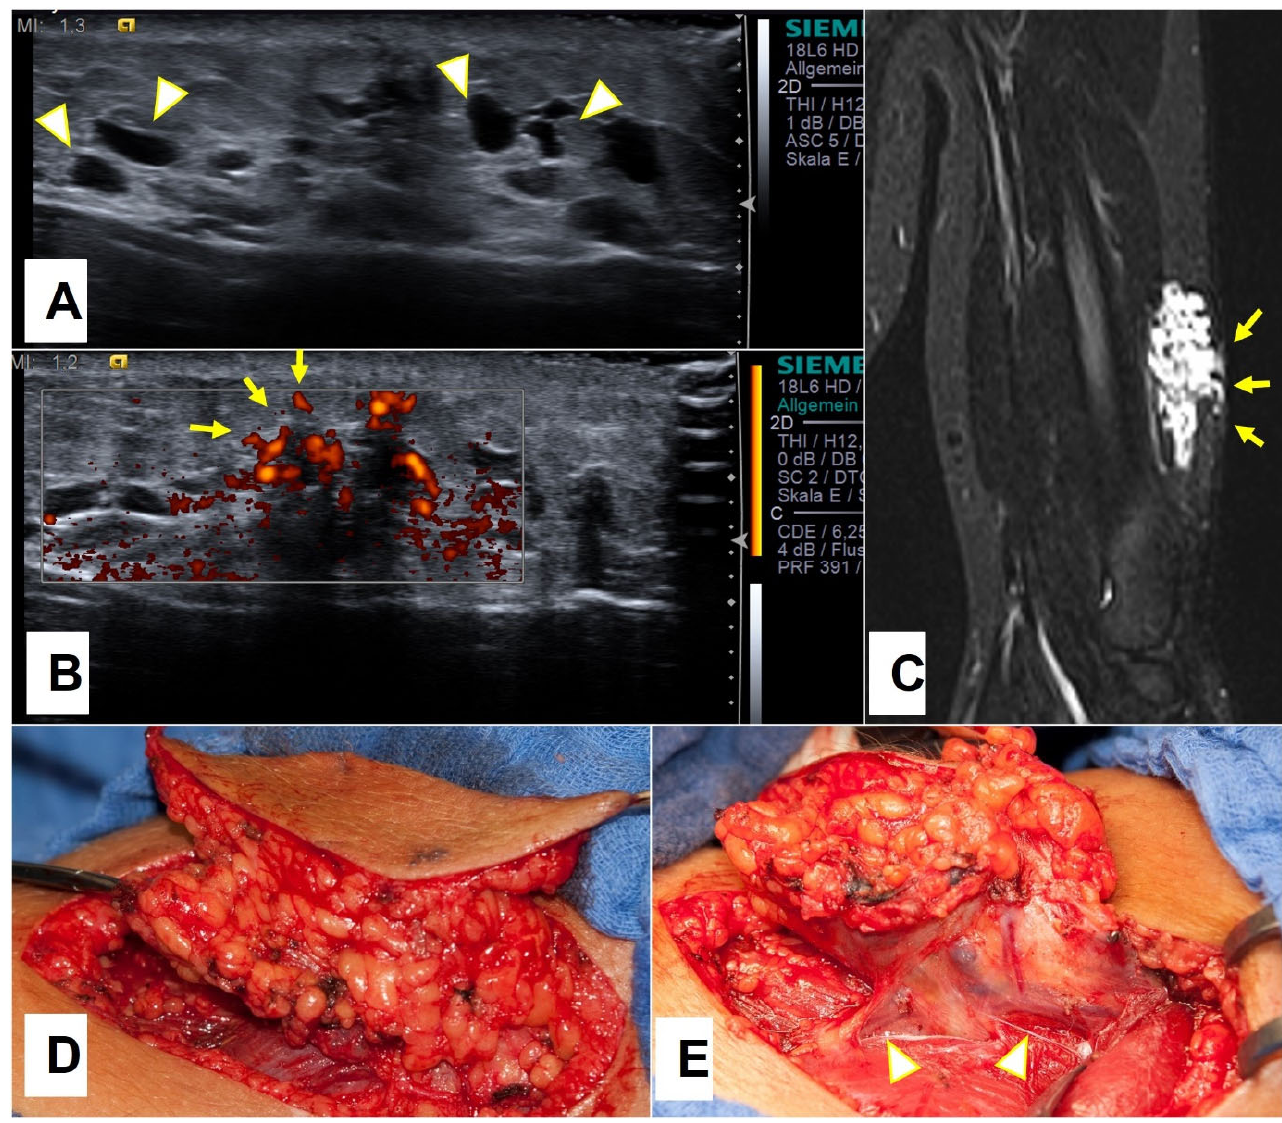
Figure 6. A 14.5 ‐ year ‐ old boy was presented because of the minor swelling on his left upper arm, which appeared after he started to go to the gym. Ultrasound imaging showed a tubulo ‐ cystic lesion (arrowheads) on the lateral aspect of his upper arm ( A ) which showed perfusion (arrows) in a power Doppler mode with venous flow characteristics ( B ). MRI depicted a venous malformation (arrows) of the localized extension located in the subcutaneous area ( C ). Complete excision of the VM was performed ( D ). Draining veins are depicted with arrowheads ( E ).